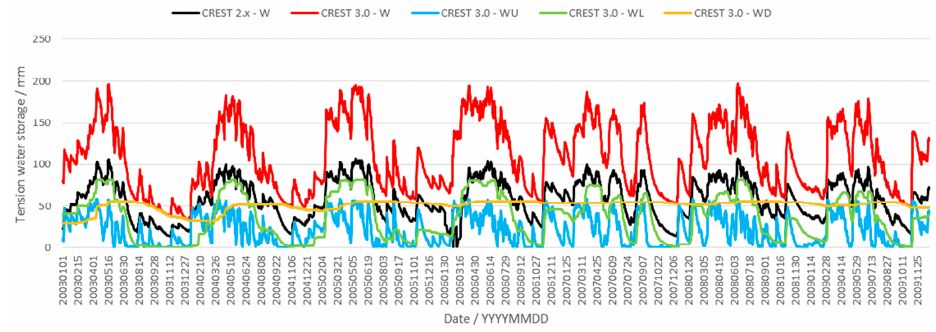
Figure 5. Simulated tension water storage of CREST 2.x and 3.0 models. W: total soil moisture; WL: lower layer soil moisture; WU: upper layer soil moisture.